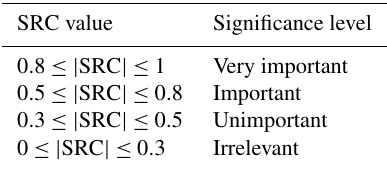
Table 1. The significance level of the input parameter to the model output